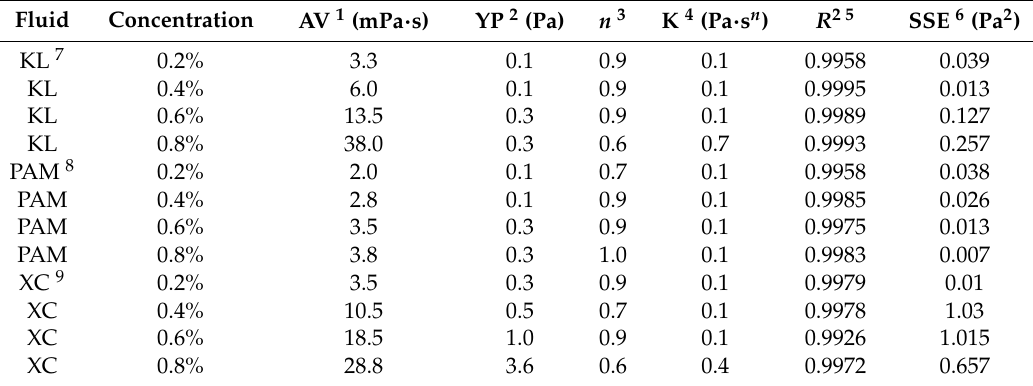
Table 3. Rheological parameters of different concentrations of polymer drilling